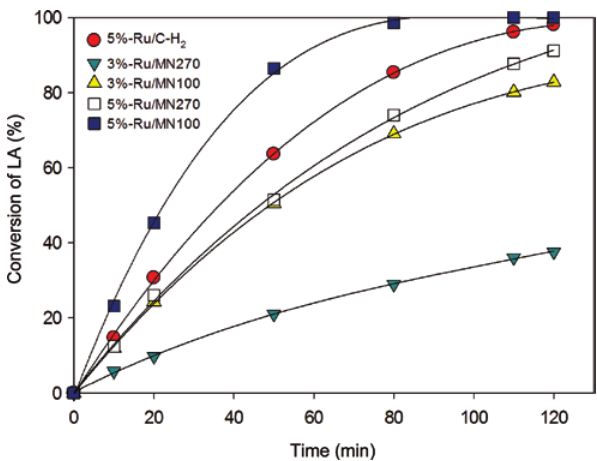
Figure 2: Comparison of kinetic curves of levulinic acid (LA) hydro- genation over 5%-Ru/C-H and Ru/hypercrosslinked polystyrene 2 (HPS) catalysts (temperature 100 ° C, H partial pressure 2 MPa, LA- 2 to-catalyst ratio 100 g/g).